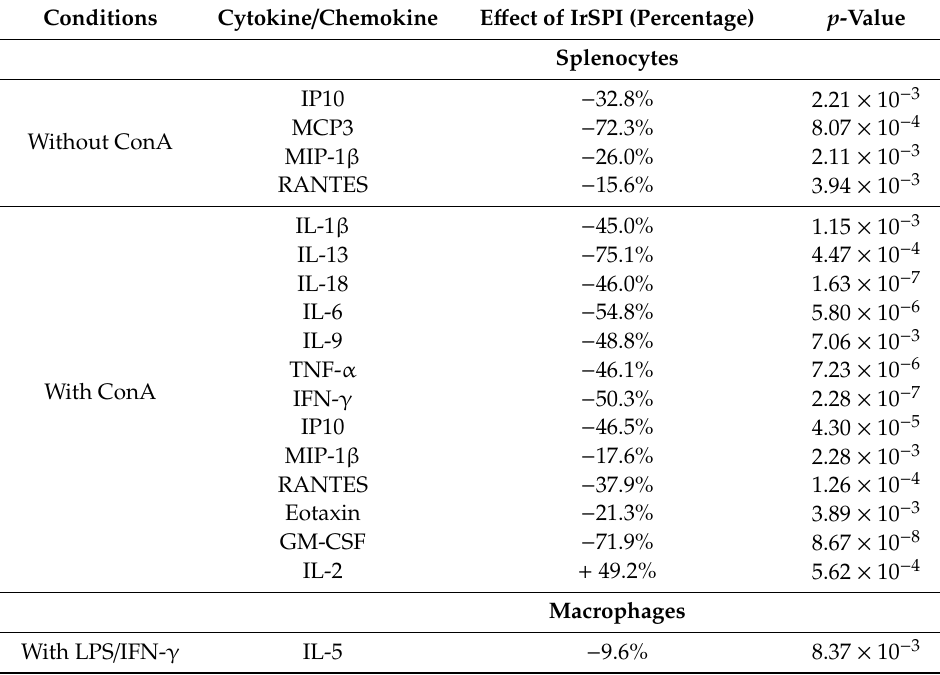
Table 1. Impact of IrSPI on murine splenocyte and macrophage cytokine / chemokine production with or without mitogen stimulation by concanavalin A